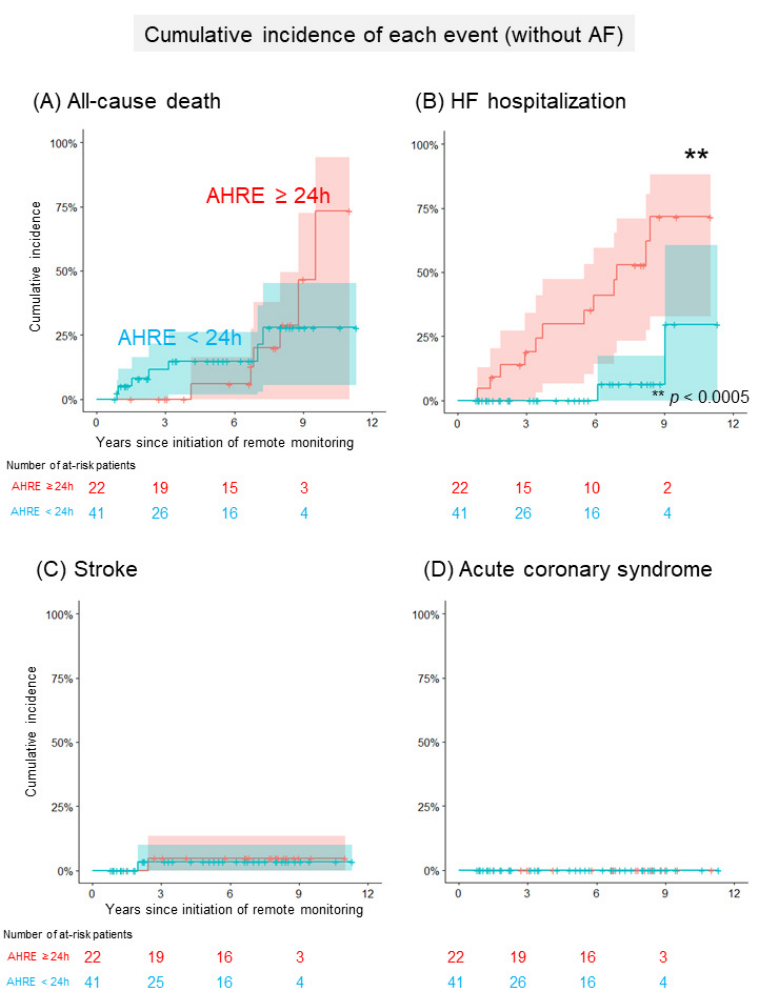
Figure 3. Comparison of the cumulative incidence of each event in patients without a history of AF. ( A ) The Kaplan–Meier curve shows the cumulative incidence and 95% CI of all-cause deaths following the initiation of remote monitoring in patients without a history of AF (red: patients with